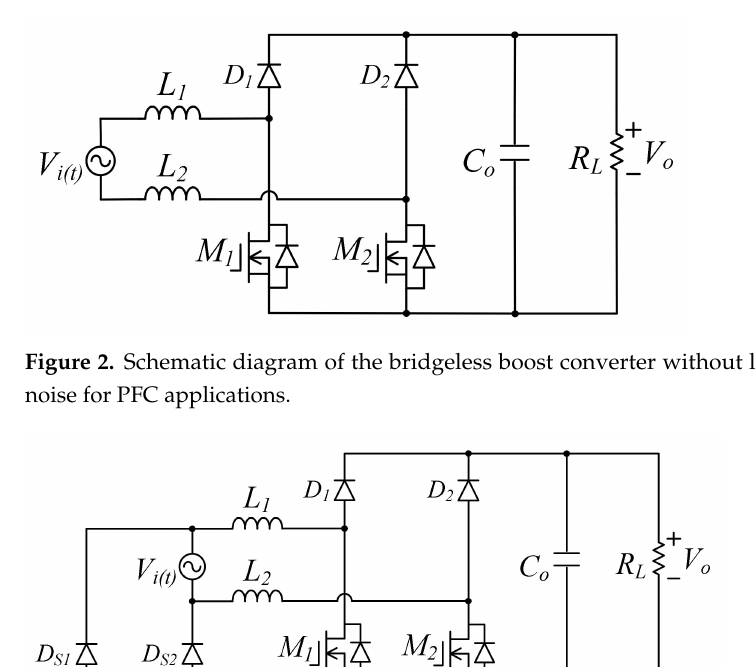
Figure 1. Schematic diagram of boost converter for power factor corrector (PFC) applications.